Question: Generate an informative caption for the figure above.
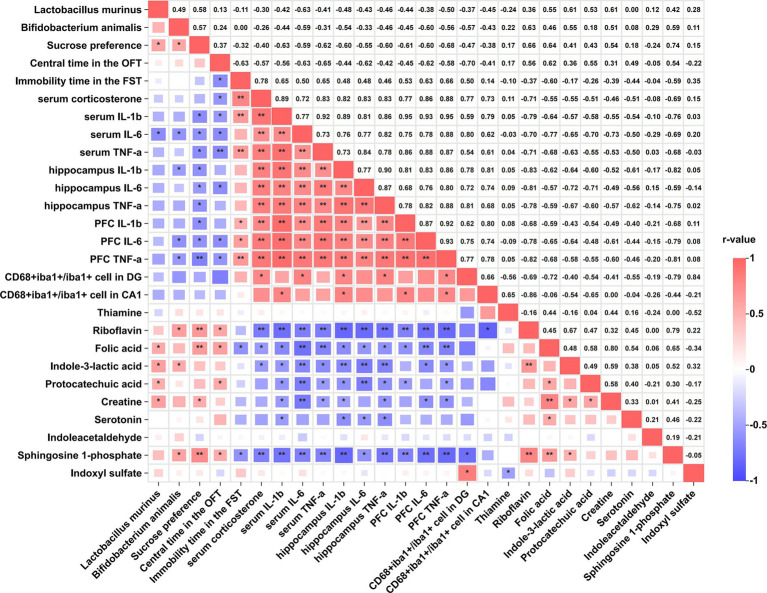
Answer: Pearson correlation analysis among depressive-like behaviors, microbial features, plasma metabolites and pro-inflammatory factors. In the upper triangle, the numbers represent the correlation coefficient r; in the lower triangle, the symbols “*” indicate significance. * p < 0.05; ** p < 0.01.